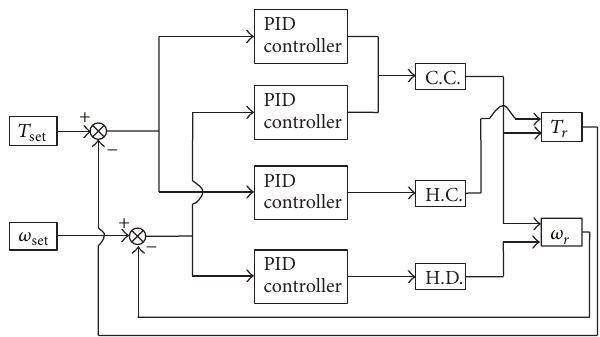
Figure 2: Overall block diagram for controlling the proposed air conditioning system.